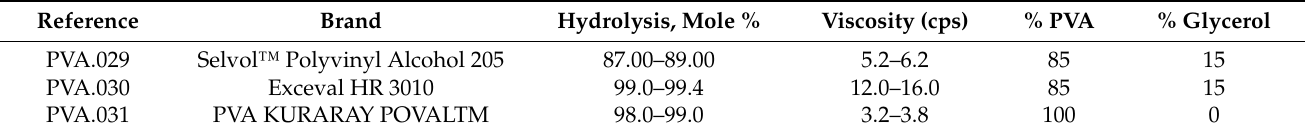
Table 1. Characteristics of the materials